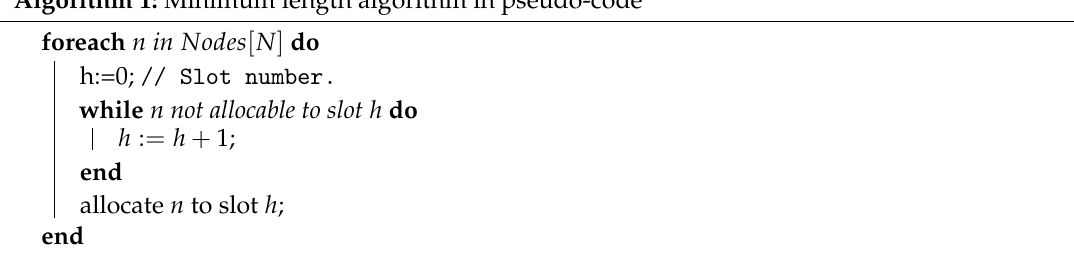
Algorithm 1: Minimum length algorithm in